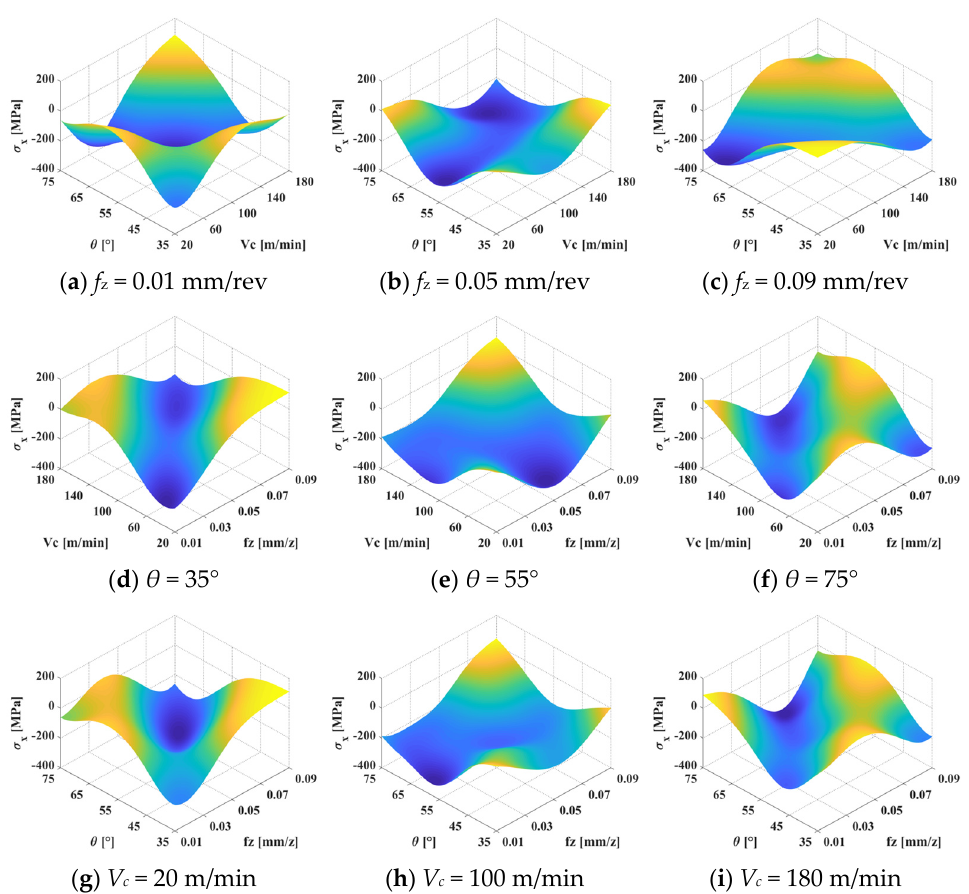
Figure 12. Interactive effects of machining parameters on surface residual stress in the σ x direction.